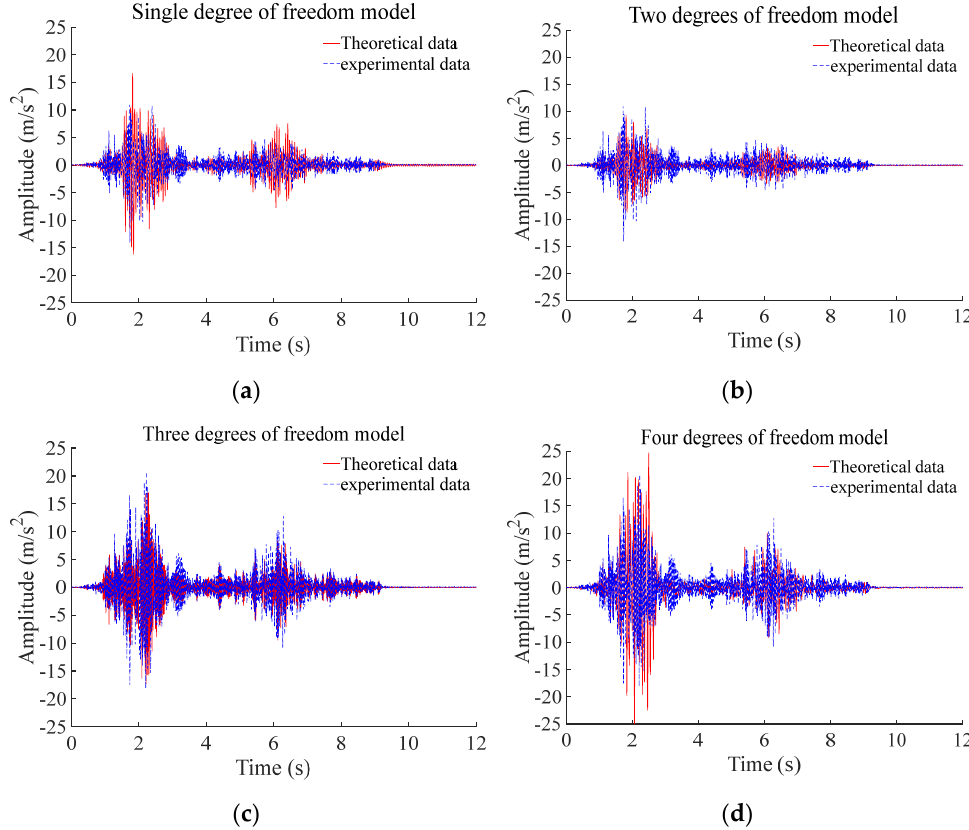
Figure 6. Comparison of theoretical solutions of four simplified models and shaking table test results: ( a ) Acceleration time history comparison of 1 − DOF; ( b ) Acceleration time history comparison of 2 − DOF; ( c ) Acceleration time history comparison of 3 − DOF; ( d ) Acceleration time history comparison of 4 −